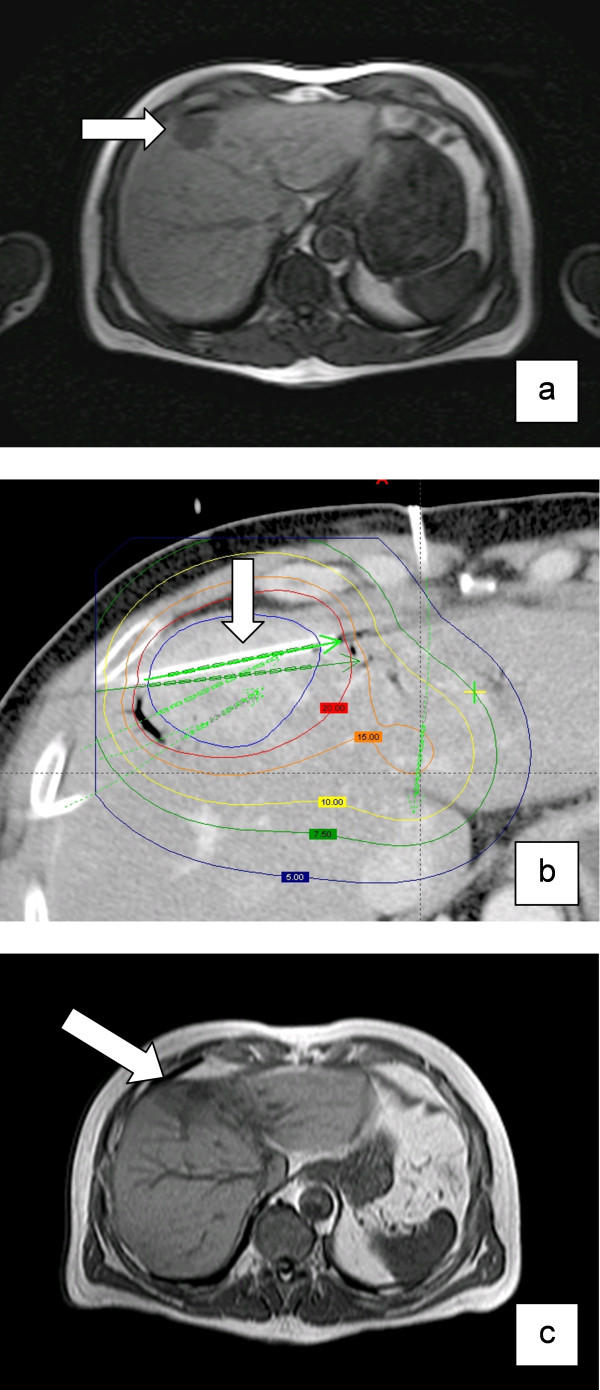
Development of radiation injury of the liver after HDR brachytherapy: (a) Colorectal metastasis in liver segment IV (arrow), T1w-GRE 20 minutes after application of Gd-BOPTA. (b) Contrast-enhanced planning-CT and dosimetry after insertion of brachytherapy catheters (arrow) in the metastasis. The coloured lines indicate different isodoses. Applicated dose at the tumor margin was 20 Gy. (c) MRI after 3 months with a decreased uptake (arrow) of Gd-BOPTA around the irradiated and shrunken metastasis (T1w-GRE 20 minutes after application of Gd-BOPTA).